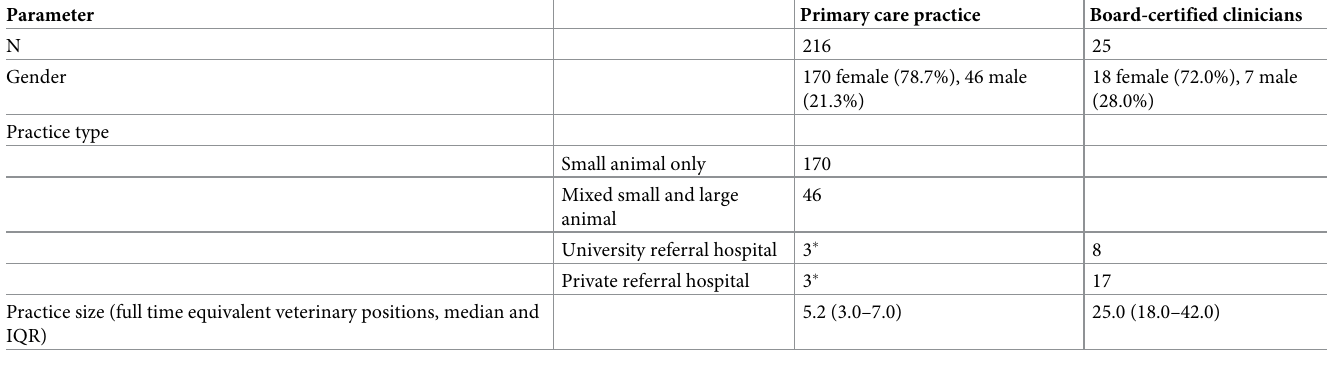
Table 1. Demographic characteristics of questionnaire